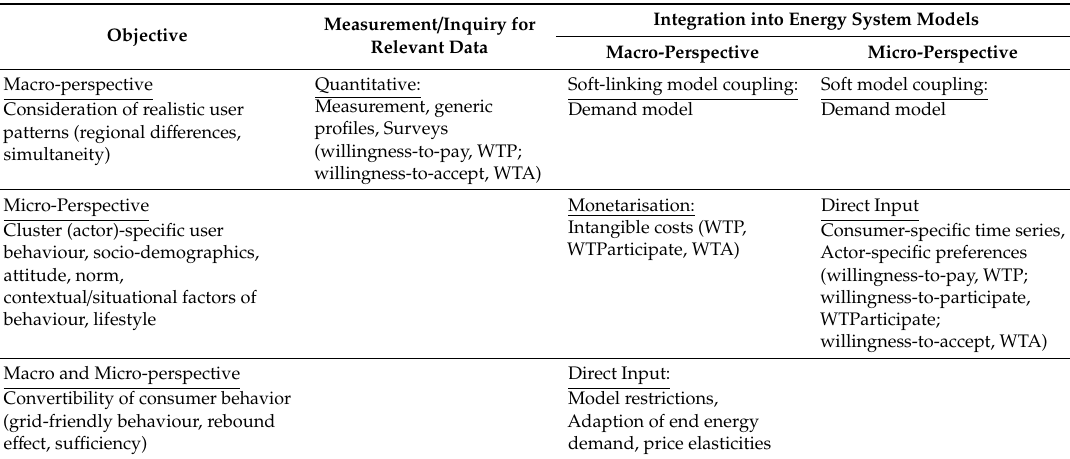
Table 3. Overview of objectives, methods of empirical data inquiry and possibilities to integrate behavioural aspects into energy system models